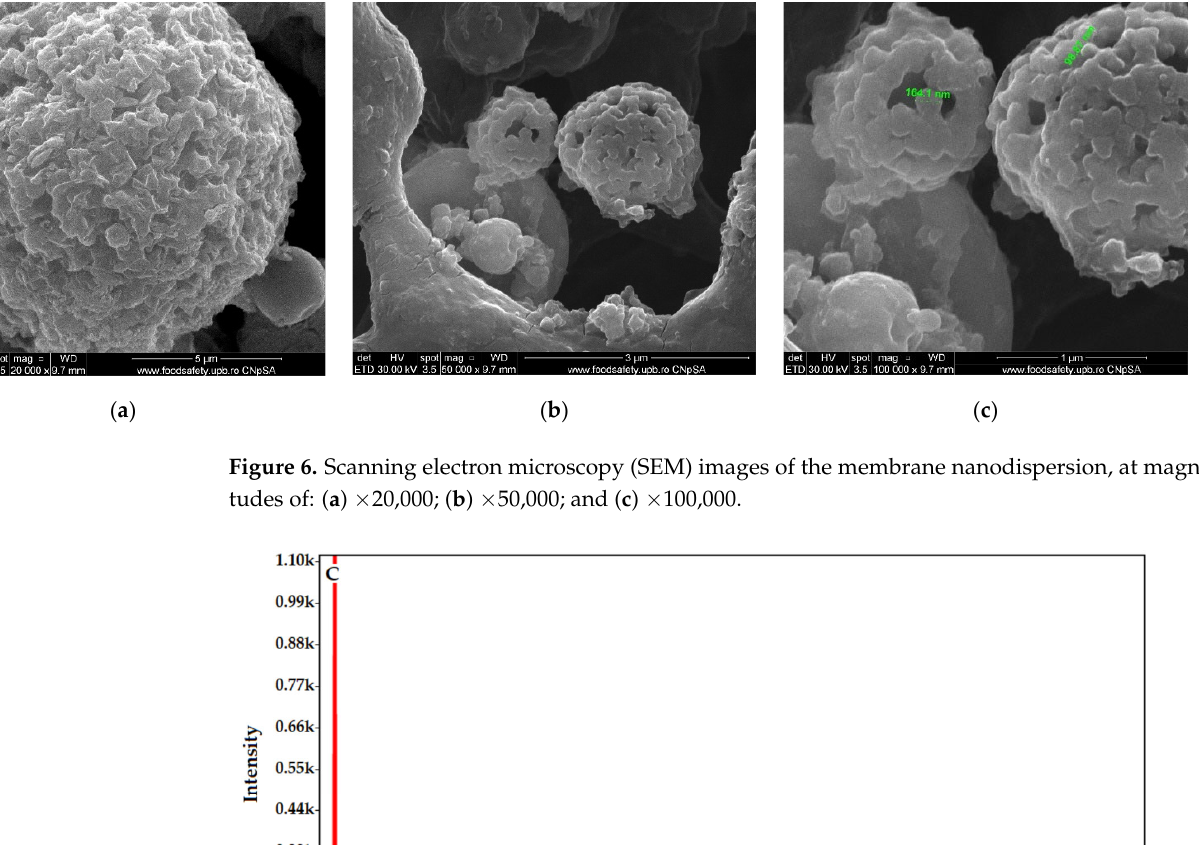
Figure 7. The surface spectrum of the membrane nanodispersion sample obtained by energy ‐ dis ‐ persive spectroscopy analysis (EDAX).